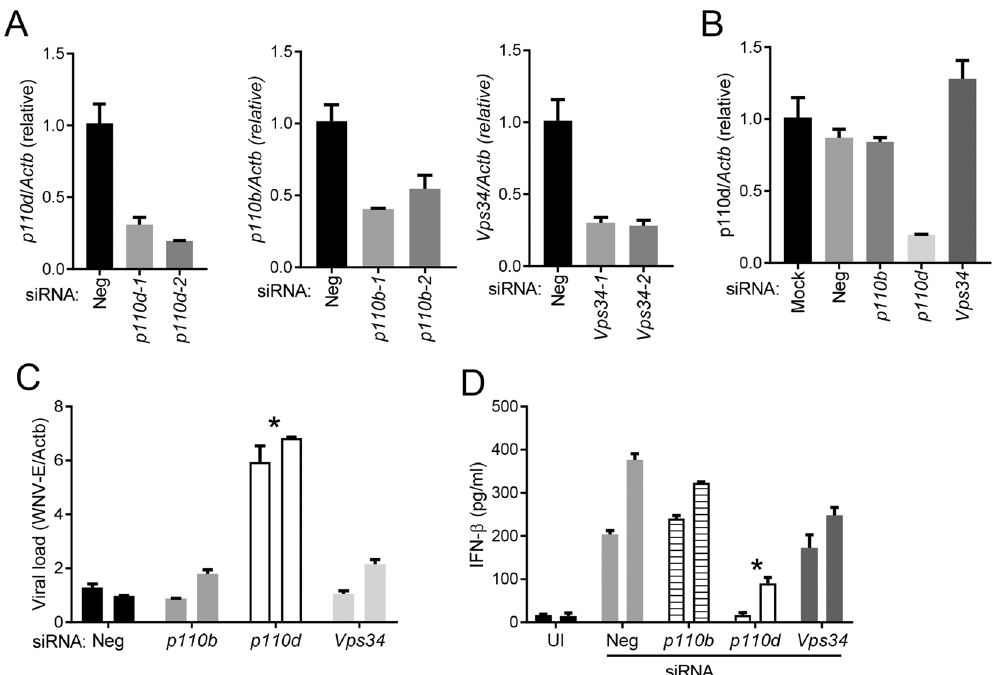
Figure 5. siRNA knock down of the PI3K catalytic p110 δ reduces antiviral immune responses. The scrambled (Neg) or p110-targeting siRNA was electroporated into BMDMs, 48 h later the BMDMs were infected with WNV for 24 h. ( A , B ) The mRNA abundances of p110 isoforms were quantified by q-PCR after WNV infection. The results are expressed as fold change over Neg in ( A ) or Mock transfected in ( B ). ( C ) The cellular viral loads were quantified by q-PCR. The data are expressed as fold change over Neg. ( D ) ELISA of IFN- β in the cell culture medium. UI, uninfected. * p < 0.05 (unpaired Student’s T-test), Bar: the mean of the result + s.e.m. The data shown are representative of 3 independent reproducible